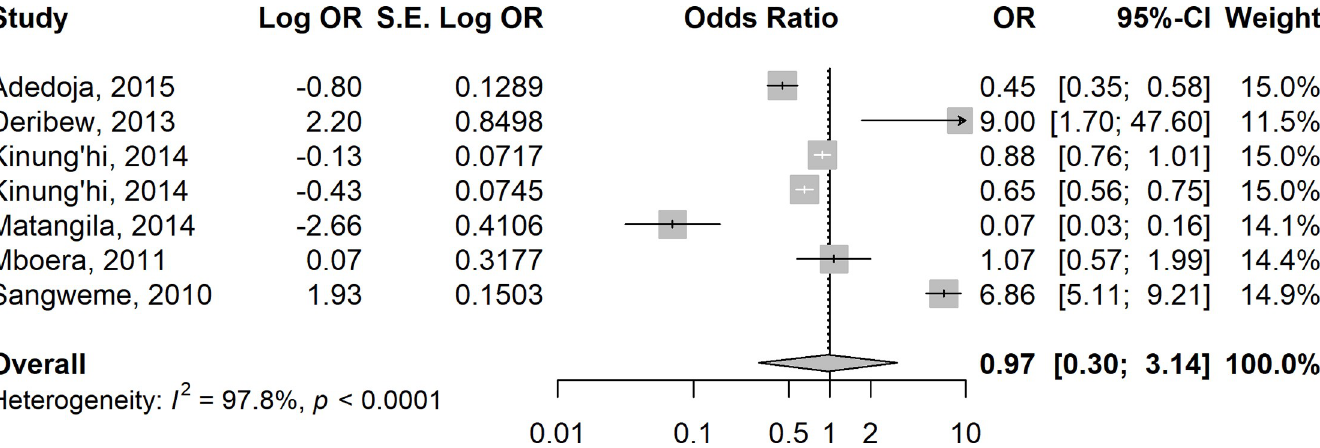
PLOS NeglectedTropical Diseases | https://doi.org/10.1371/journal.pntd.0009138 February 18,